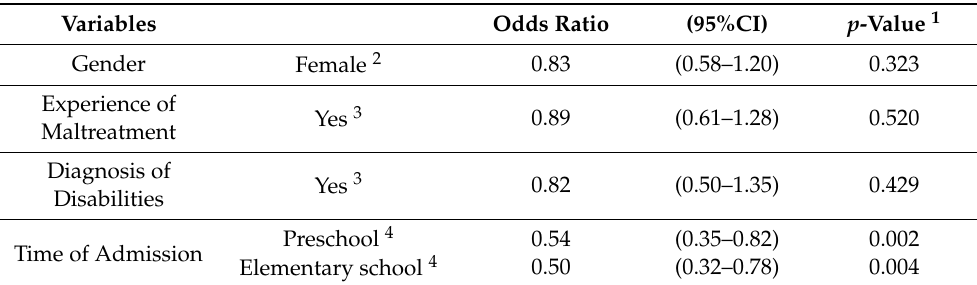
Table 3. Logistic regression models of high school